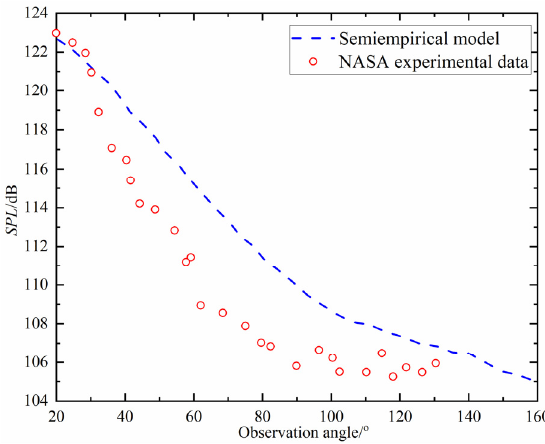
Figure 2. Comparison results between simulation and experiment data.